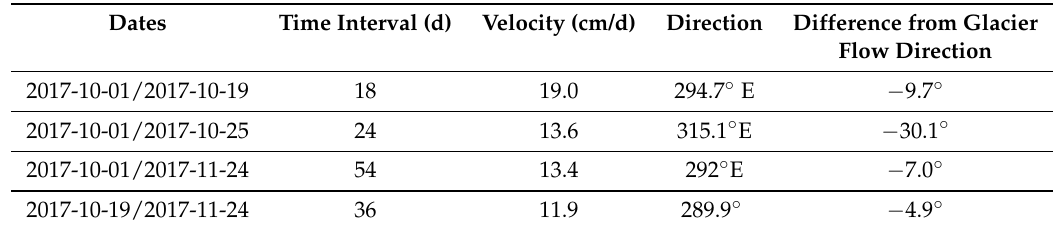
Table 5. Distance covered by CR8 between two successive positions and the corresponding velocity.